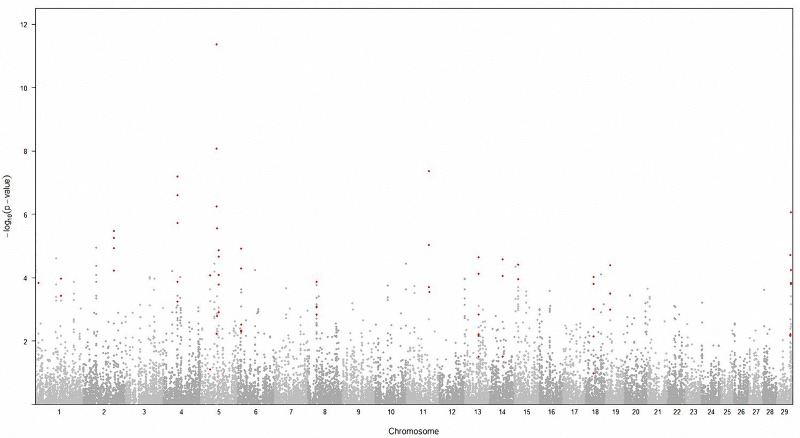
Genomic regions with selection signals in the Brown Hanwoo vs. a pooled unselected population using Rsb statistic.Red dots indicate significant markers remaining after FDR correction.